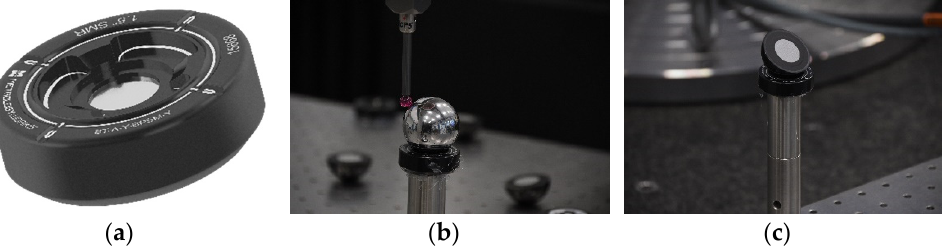
Figure 11. SMR ( a ) as an element in order to have a common reference geometry for calibration with the CMM through a sphere ( b ) or the photogrammetry through a split bearing with a retro reflective marker ( c ).